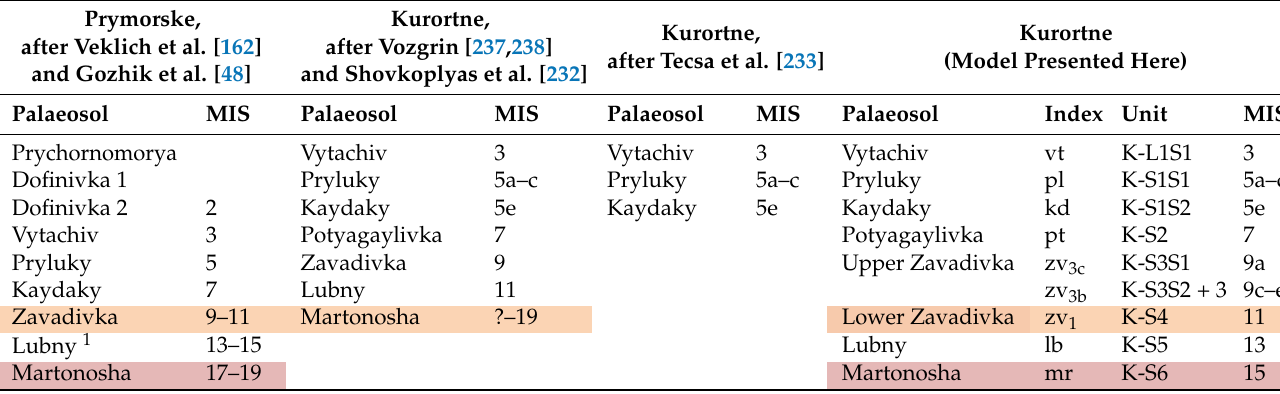
Table 3. Chronostratigraphic models proposed for the Kurortne/Prymorske loess sequence.